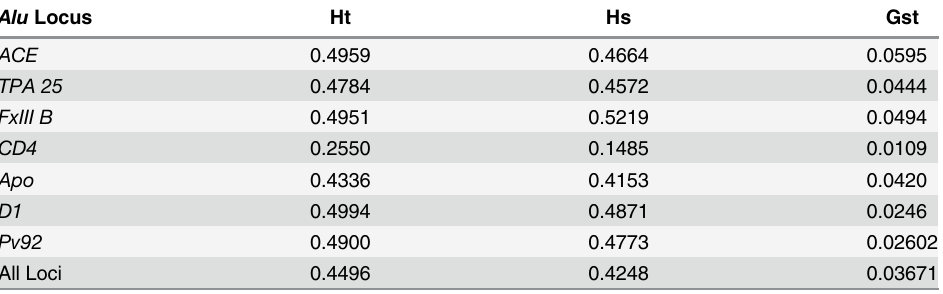
Table 4. Analysis of gene diversity for individual loci considered jointly between populations. Alu Locus Ht Hs